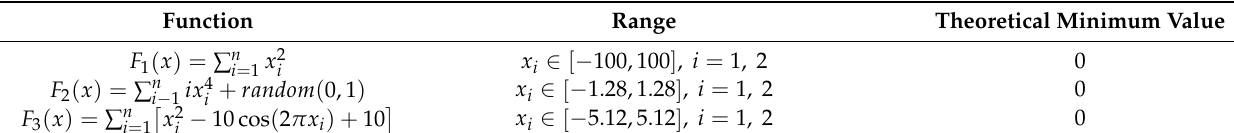
Table 3. Three benchmark functions.